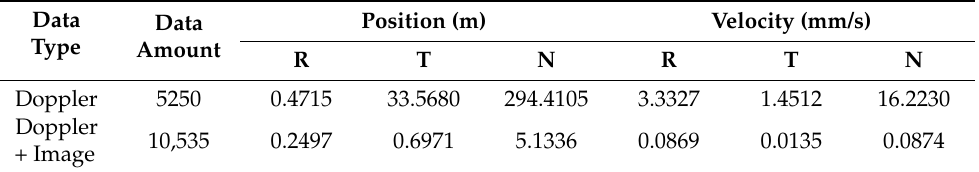
Table 5. RMS of orbital difference between initial spacecraft states computed with different data types and a “true” initial spacecraft state. “R”, “T”, and “N” denote radial, tangential, and normal directions,